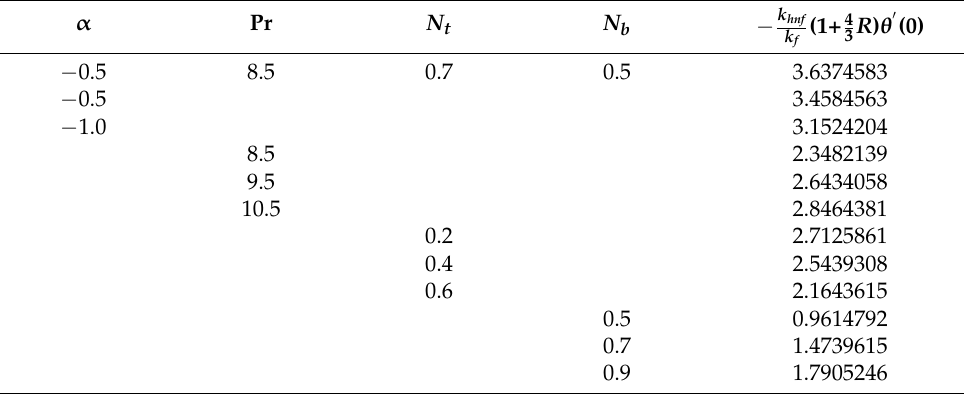
Table 4. The effect on the Nusselt number − k hnf physical parameters.